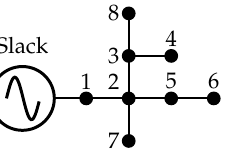
Figure 6. Electrical configuration of the 8-node system.